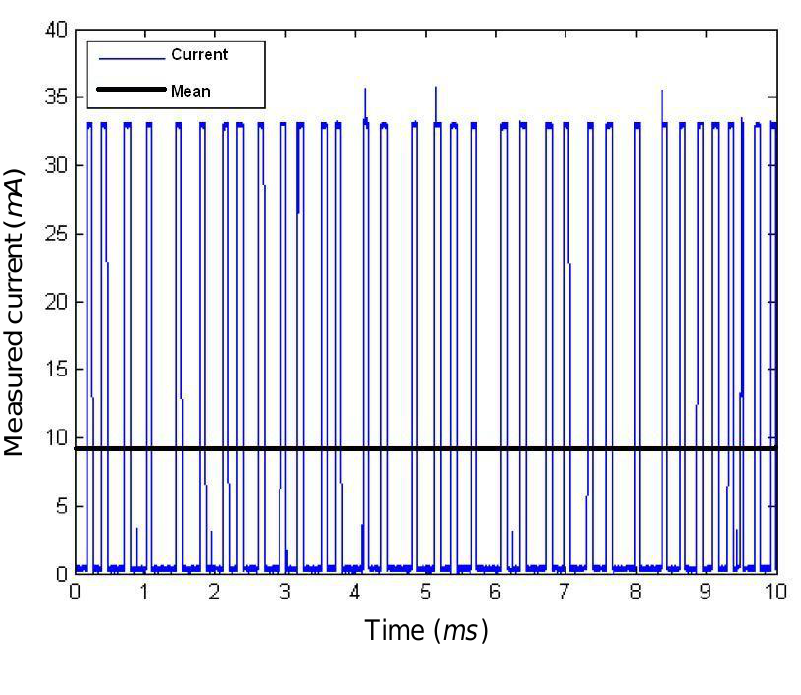
Figure 5. Drained current during orphan